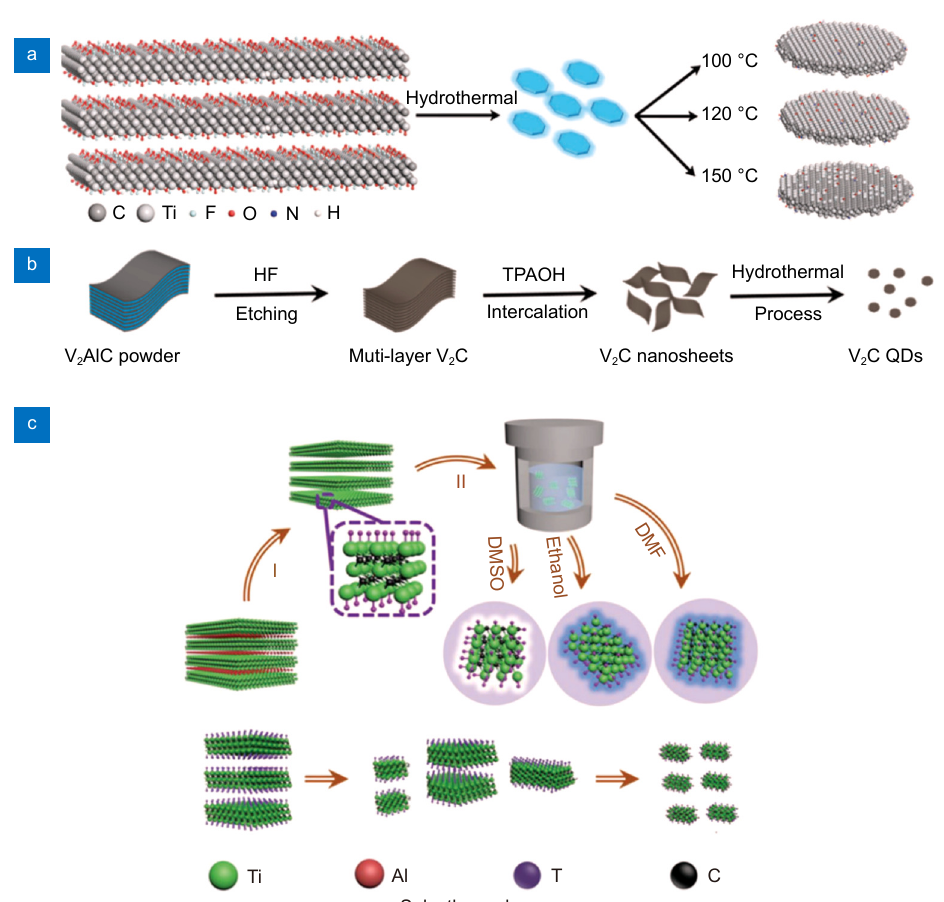
Fig. 2 | Hydrothermal and solvothermal synthesis processes. The figures were reproduced with permission from: ( a ) ref. 29 , Copyright 2017, John Wiley and Sons; ( b ) ref. 68 , Copyright 2019, Elsevier; ( c ) ref. 70 , Copyright 2018, John Wiley and